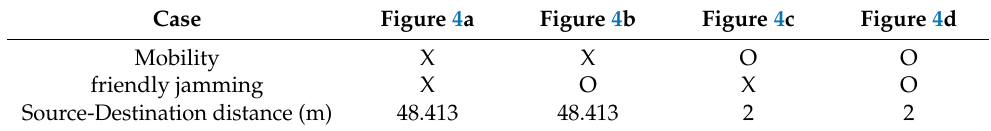
Table 3. Environment setting of Figure